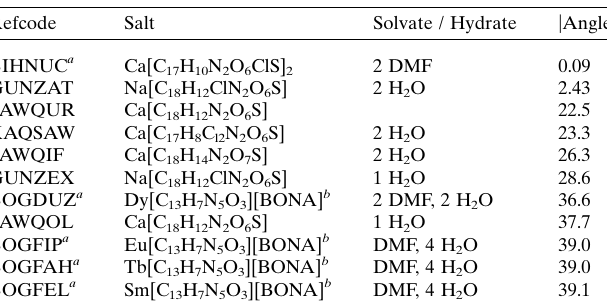
Table 2 Angles ( (cid:4) ) of the C–COO(H) plane to the mean plane of the carbon skeleton of the (cid:3) -oxynaphthoic acid